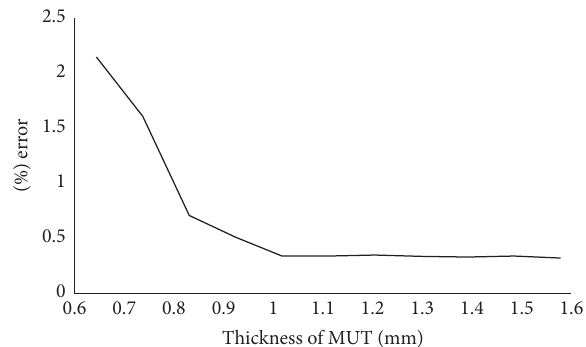
Figure 13: The percentages error in phase shift versus thickness of MUT.